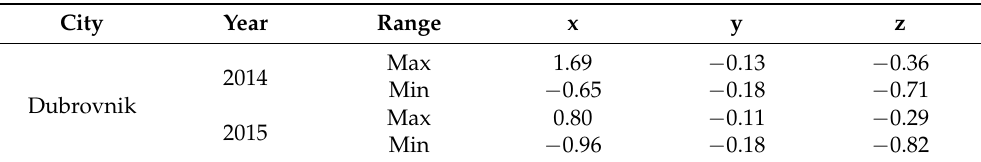
Table 7. Values of the RTE corrections based on the proposed model for the Dubrovnik GNSS location (in m).